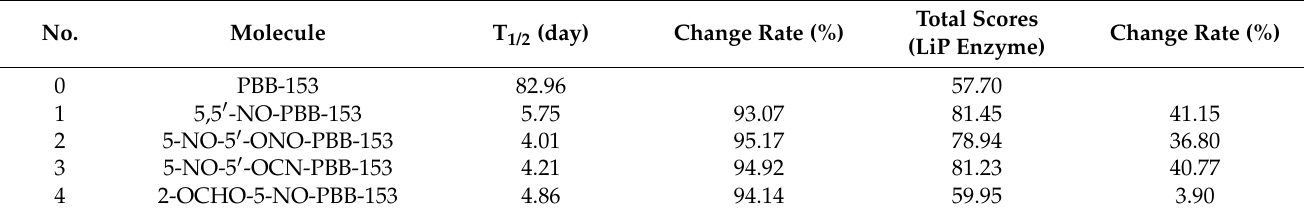
Table 8. Calculation of half-life in air and total scores of PBB-153 docking with lignin peroxidase (LiP) enzyme before and after